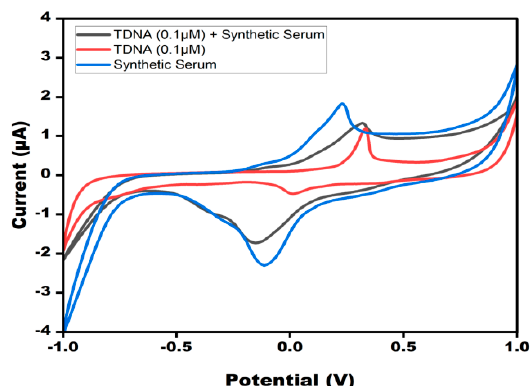
Figure 7. CV peak current study of TDNA of ZIKV in synthetic serum at modified DNA probe/AgNPs/PBGs in10 mM methylene blue in 0.1 M KCl at 50 mV s − 1 in the potential range from − 1 V to +1 V. CV peak current was compared with the synthetic serum, TDNA, and TDNA in syn- thetic serum.